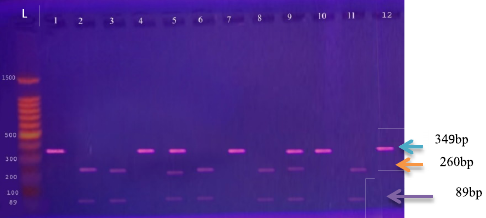
Fig. 3 . Agarose gel electrophoresis of 1.5% at 70volt for 45min, show restriction digestion pattern of MBL -54 A/G polymorphisms of gene using BanI enzyme. L: 1500 DNA ladder. Lanes2, 3,6,8,11 homozygous wild type (GG). Lane 1,4,7,10,12: mutant genotype (AA). Lanes5, 9: heterozygous genotype